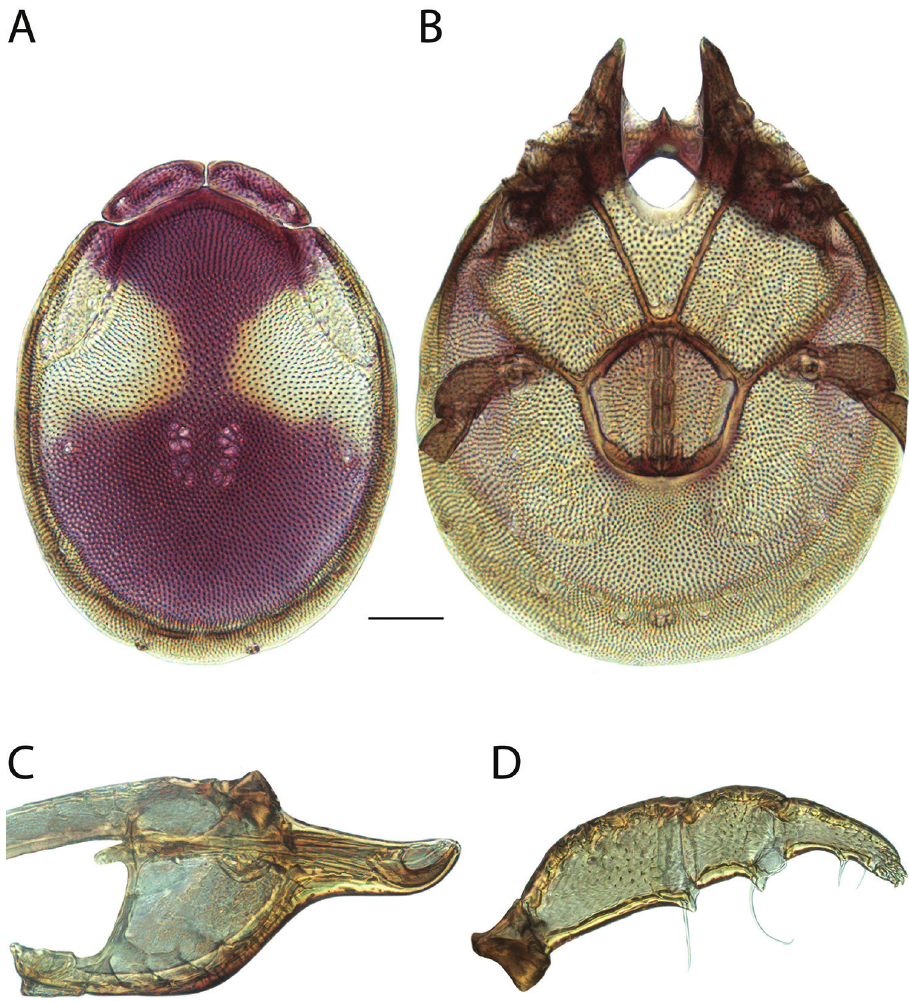
Figure 276. Torrenticola whitneyae sp. n. female: A dorsal plates B venter (legs removed) C subcapitulum D pedipalp (setae not accurately depicted). Scale = 100